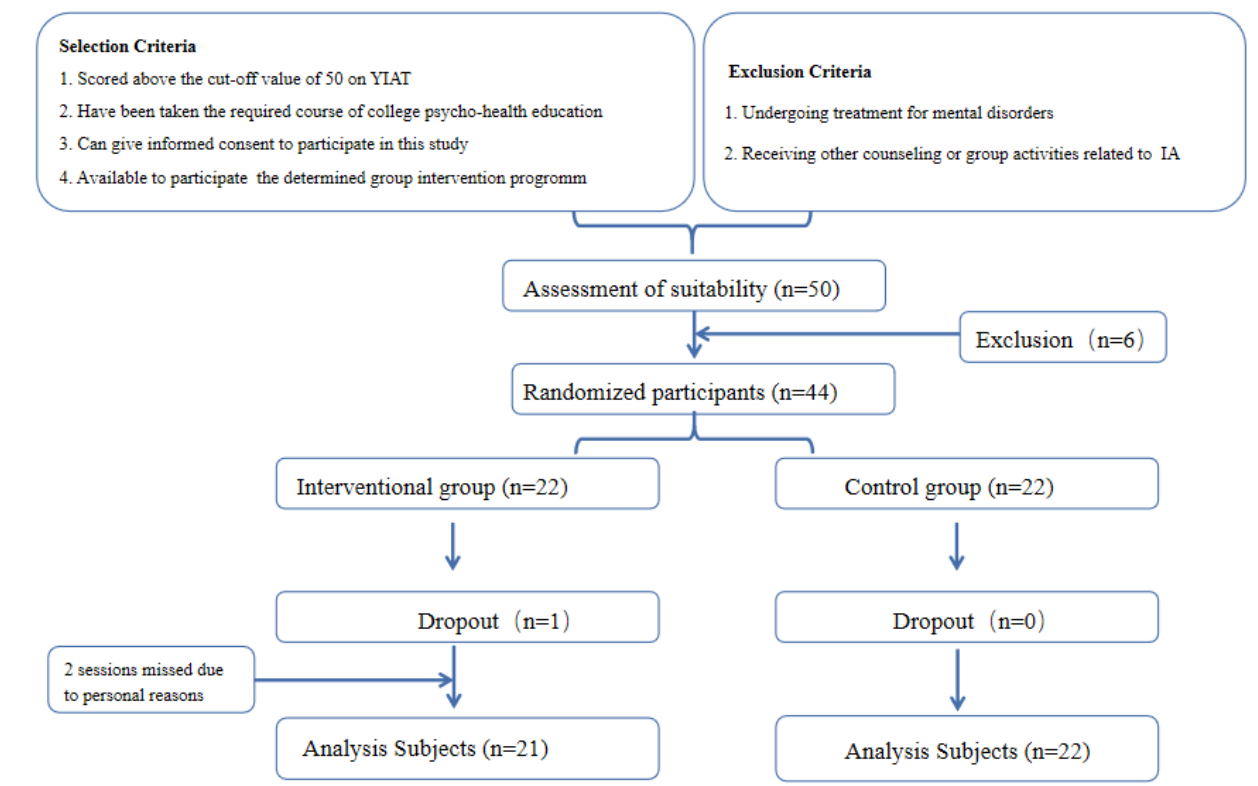
Figure 1. Flowchart of Randomized Controlled Trial Participants.